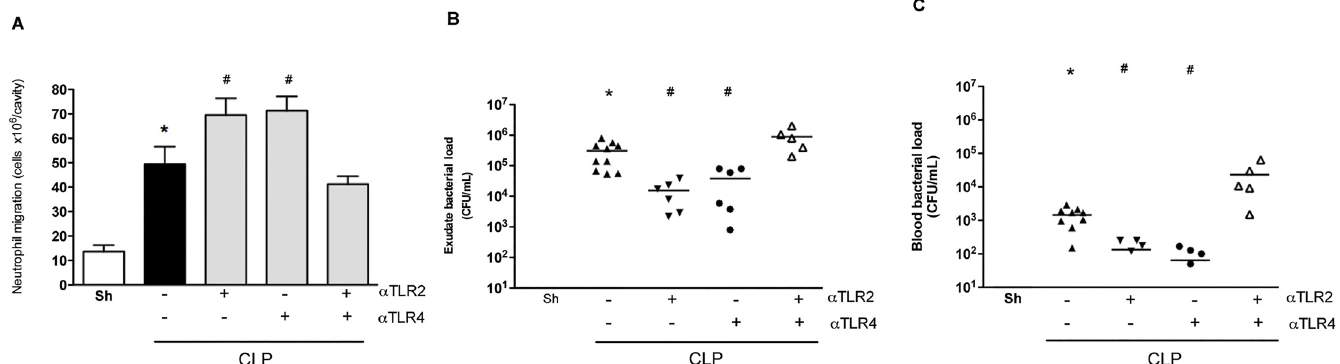
Fig 2. Blockade of either TLR2 or TLR4 improves inflammatory and infection indices in polymicrobial sepsis. Analysis of parameters of mice pre- treated (45 minutes before the CLP procedure) with individual anti-TLR2 or anti-TLR4 antibodies showed an increased neutrophil migration to the peritoneal cavity (A) and a decreased number of bacteria in peritoneum (B) and serum (C) 6 hours after sepsis compared to negative isotype IgG antibody treatment (black bar). The combined treatment with both anti-TLR2 and anti-TLR4 showed a similar inflammatory response compared to the negative control isotype IgG treated-group (CLP). * p < 0.05 between the CLP and Sham groups. # p < 0.05 between individual antibody treatments and negative control isotype IgG treated-group. Antibody dose (1 mg/animal). Horizontal bars in Fig 2A/2B represent median value. Used 6 animals/group, except isotype IgG antibody treated group (n = 10). Missing points in Figs reflect number of bacteria below detection